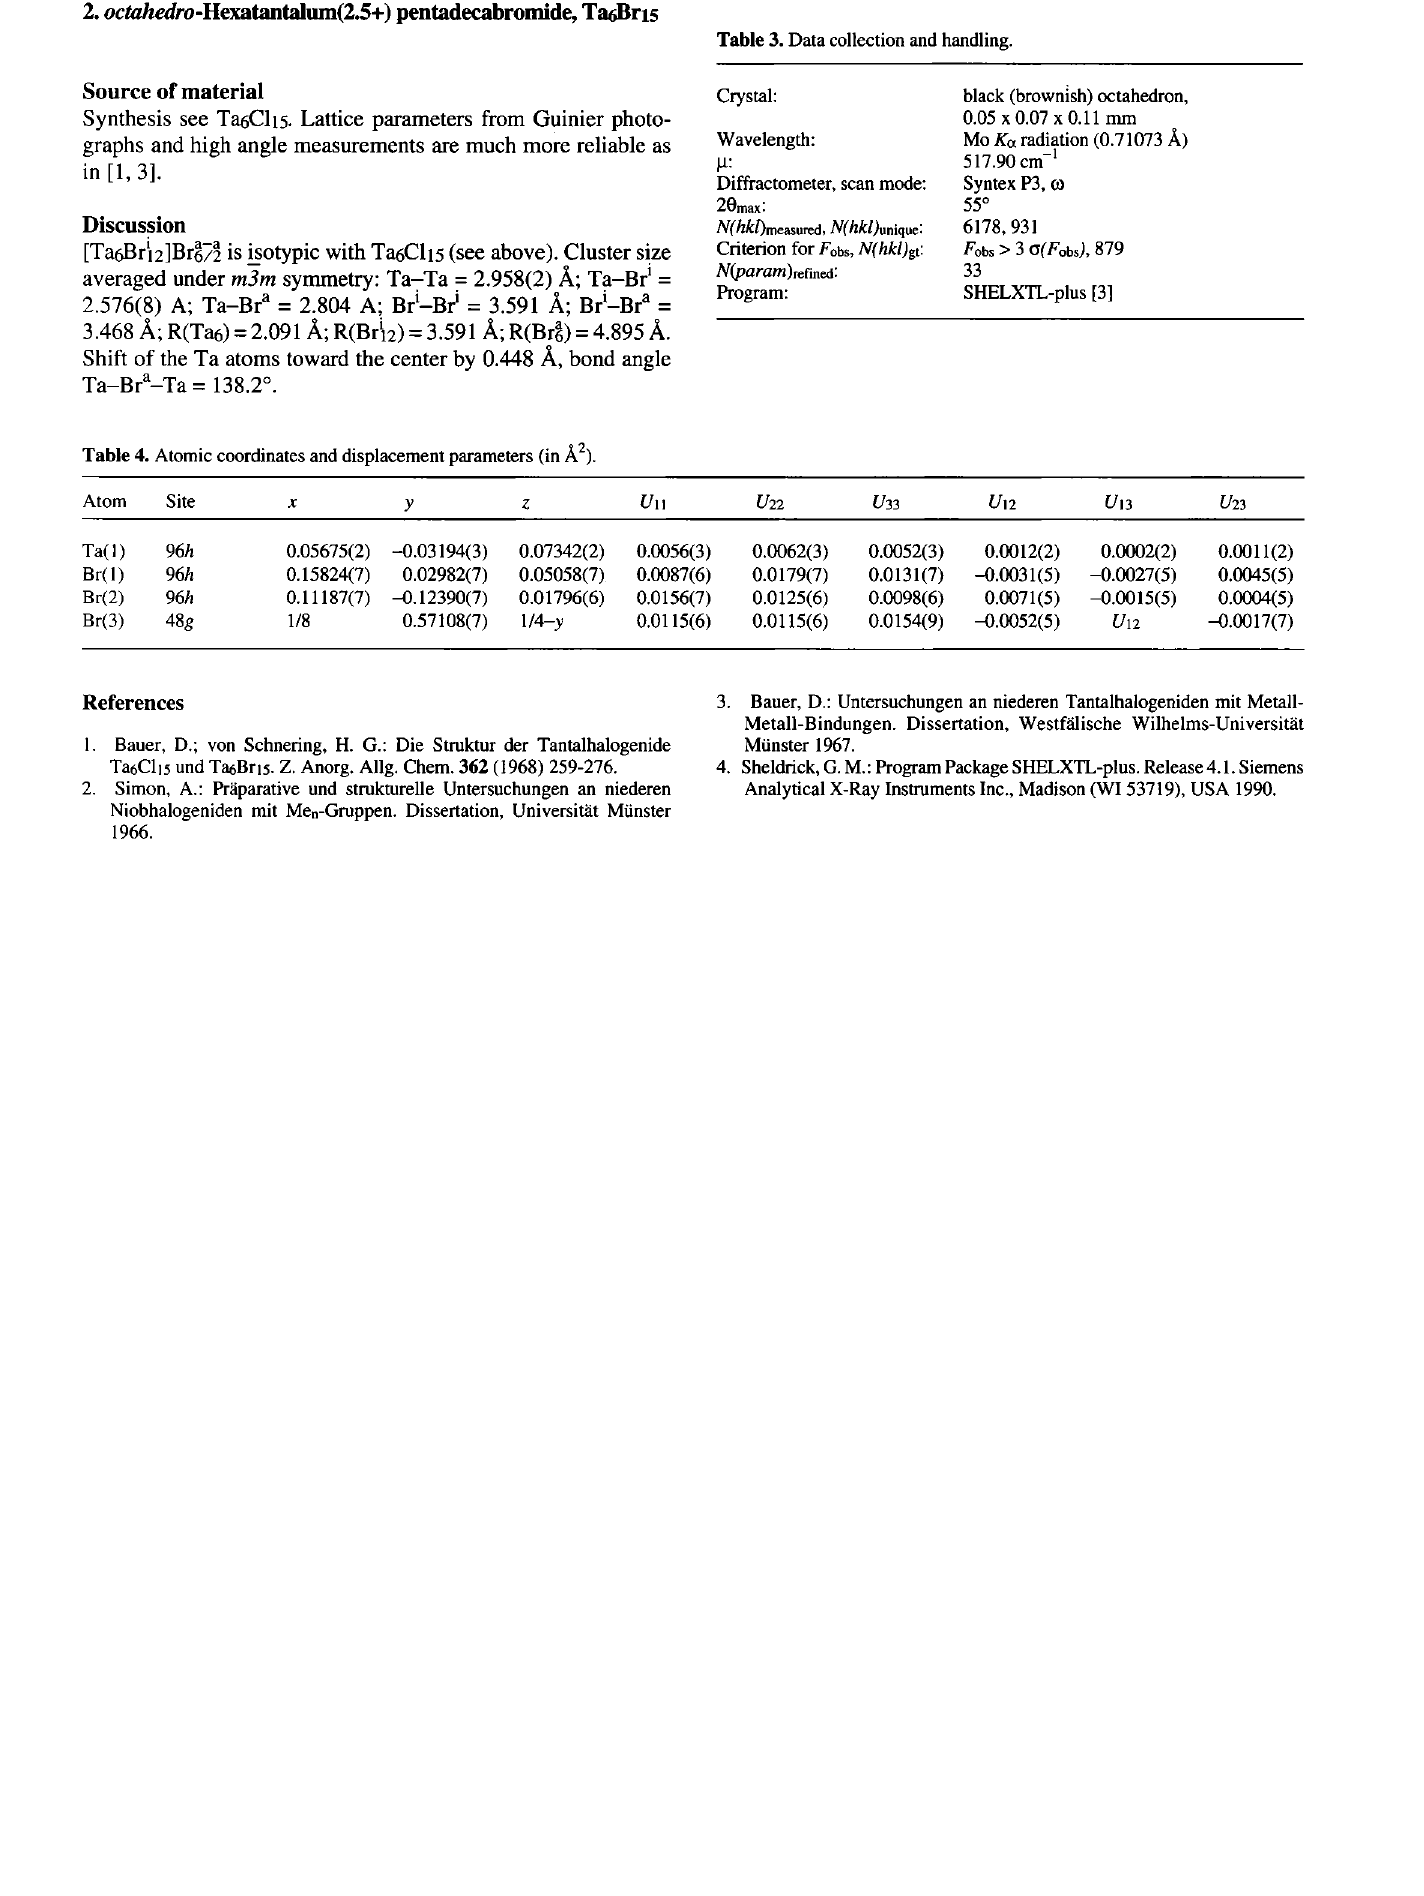
Table 3. Data collection and handling.